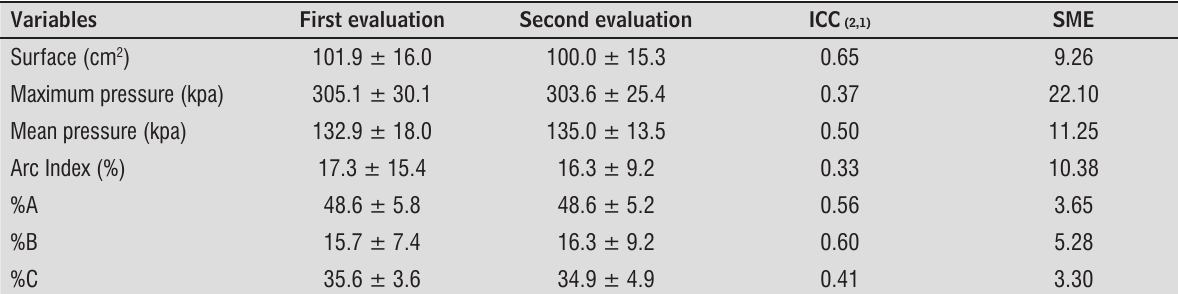
Table 2 - Descriptive analysis of baropodometric variables, relative and absolute reliability during the dynamic evaluation (n = 66) Variables First